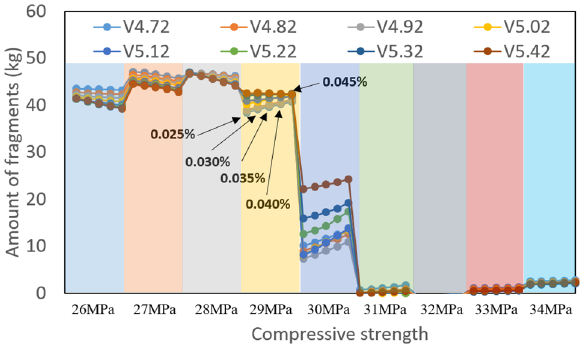
Figure 10. Amount of fragments depending upon various local impact velocities under same local impact energy.